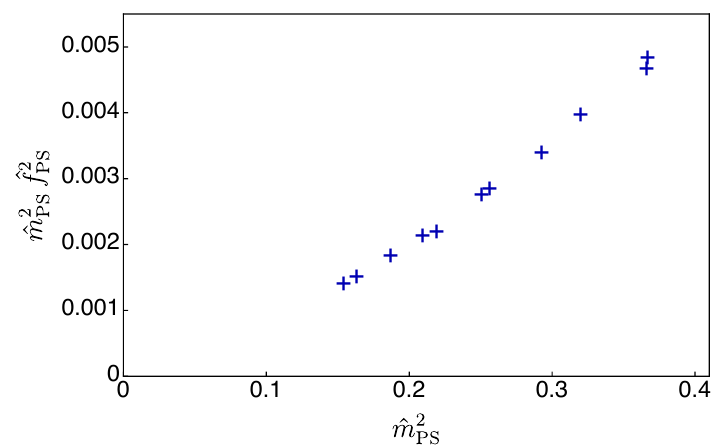
^ f 2 entering the GMOR relation, for the data set of ^ m 2 PS PS